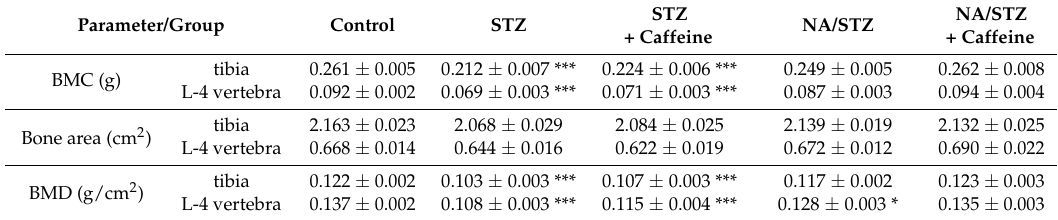
Table 2. Effect of caffeine administered orally (20 mg/kg daily for four weeks) on bone mineral content (BMC), bone area and bone mineral density (BMD) of the tibia (without the proximal epiphysis) and L-4 vertebra in rats treated with streptozotocin (STZ) or nicotinamide and streptozotocin (NA/STZ).